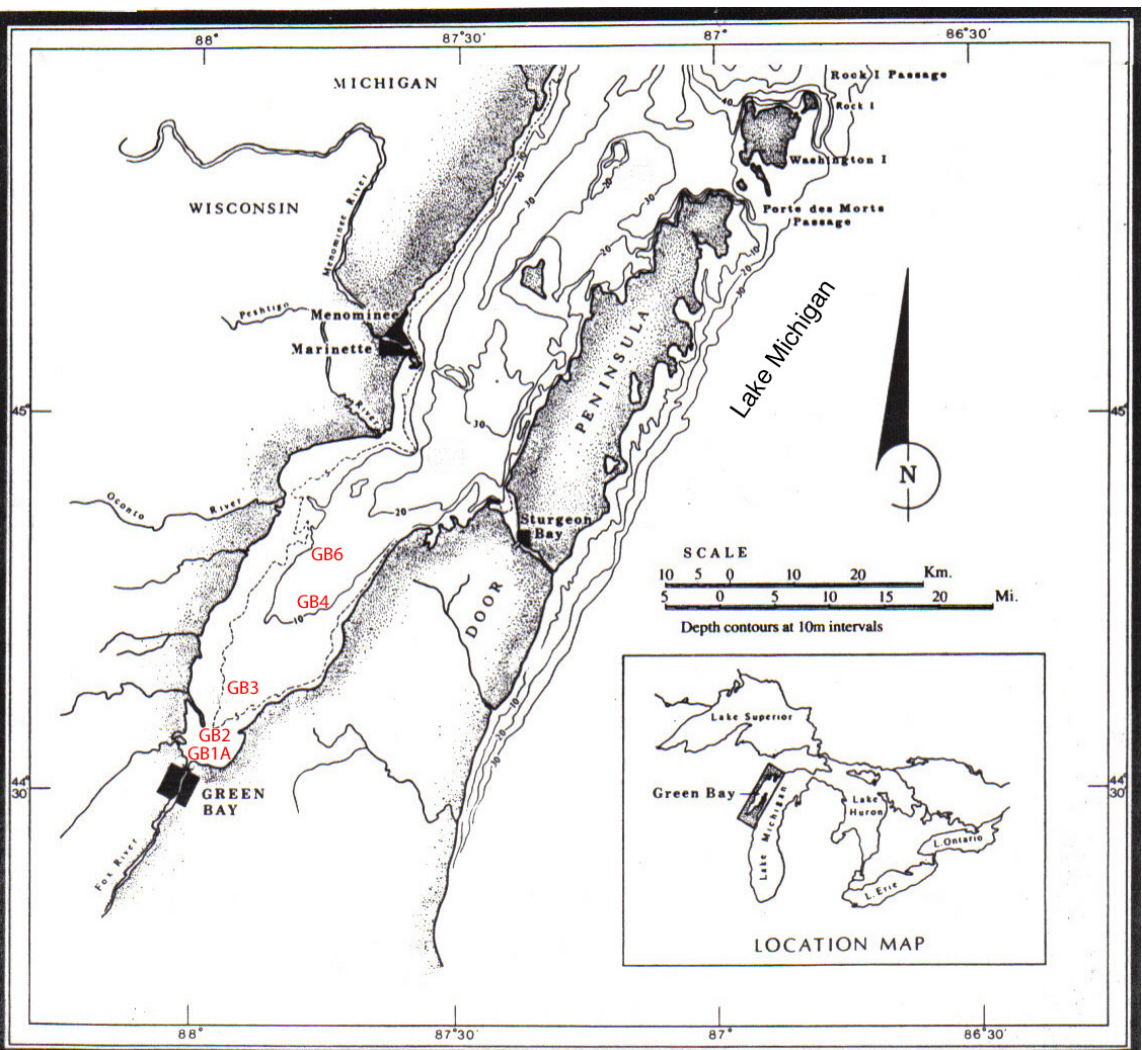
Figure 1. Map of lower Green Bay, Lake Michigan indicating sampling sites (GB1A-GB6) included in this